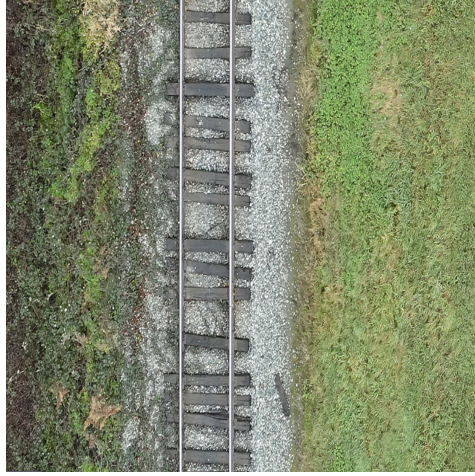
Figure 17. Negative vegetation detection. Missing ties are detected accurately by our model, as shown in Figure 18. Our model does not detect missing ties when the distance between the missing ties is uneven (see Figure 19).